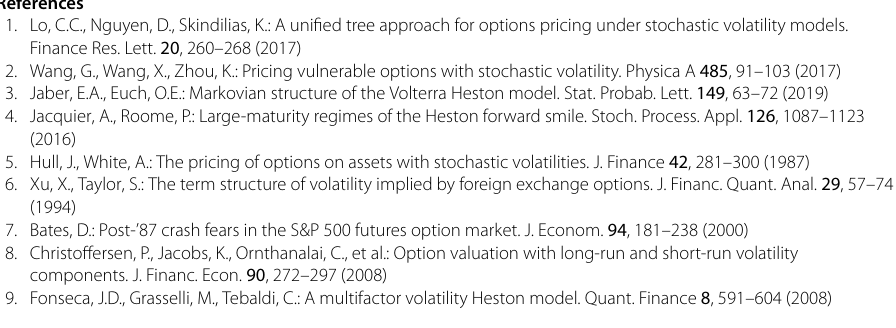
Example 2 In this example, we consider the valuation of the vulnerable call option under the mixed fractional CEV model (1.2)–(1.3). Let M = 2,000,000 and N = 20,000. Figure 3 shows the valuation of the vulnerable call option for five amounts of claims D = 10, D = 50, D = 90, and D = 130 with different s 2 . In Fig. 3, we observe that the option price has a decreasing trend of the D and an increasing trend of the s 2 . Figure 4 shows the valuation of the vulnerable call option with respect to correlation ρ 1 and s 2